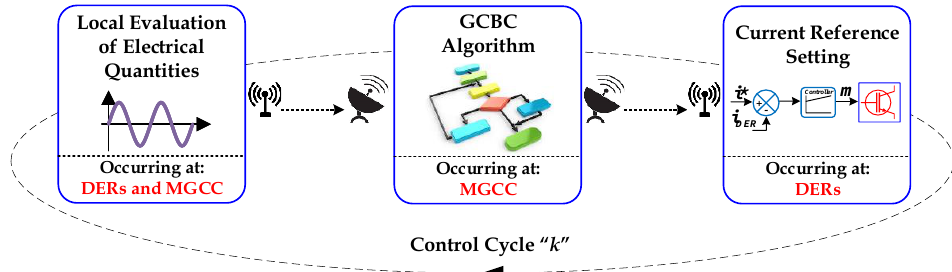
Figure 3. Three main tasks of the GCBC